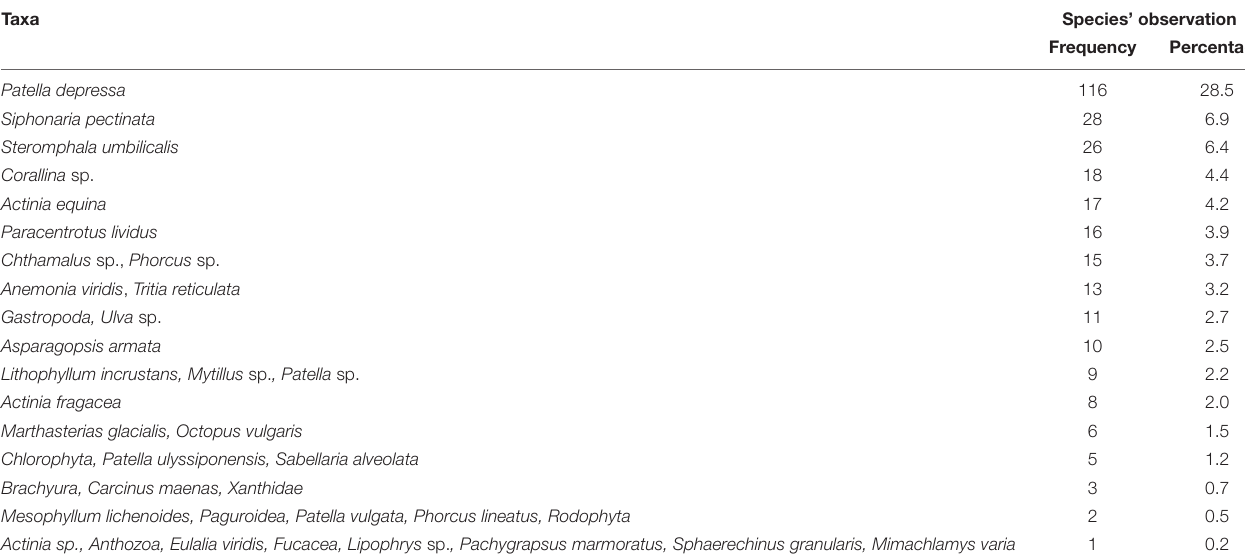
TABLE 3 | Frequency of different taxa observed by students at Avencas Beach